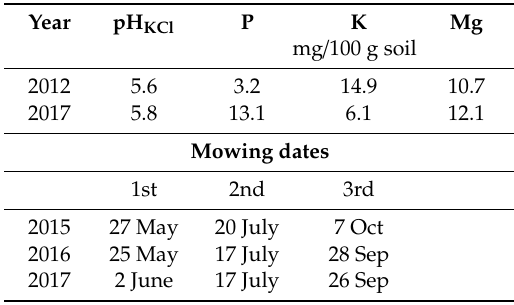
Table 1. Soil properties in the field experiment before (2015) and after study period (2017) and dates of plant mowing during the study